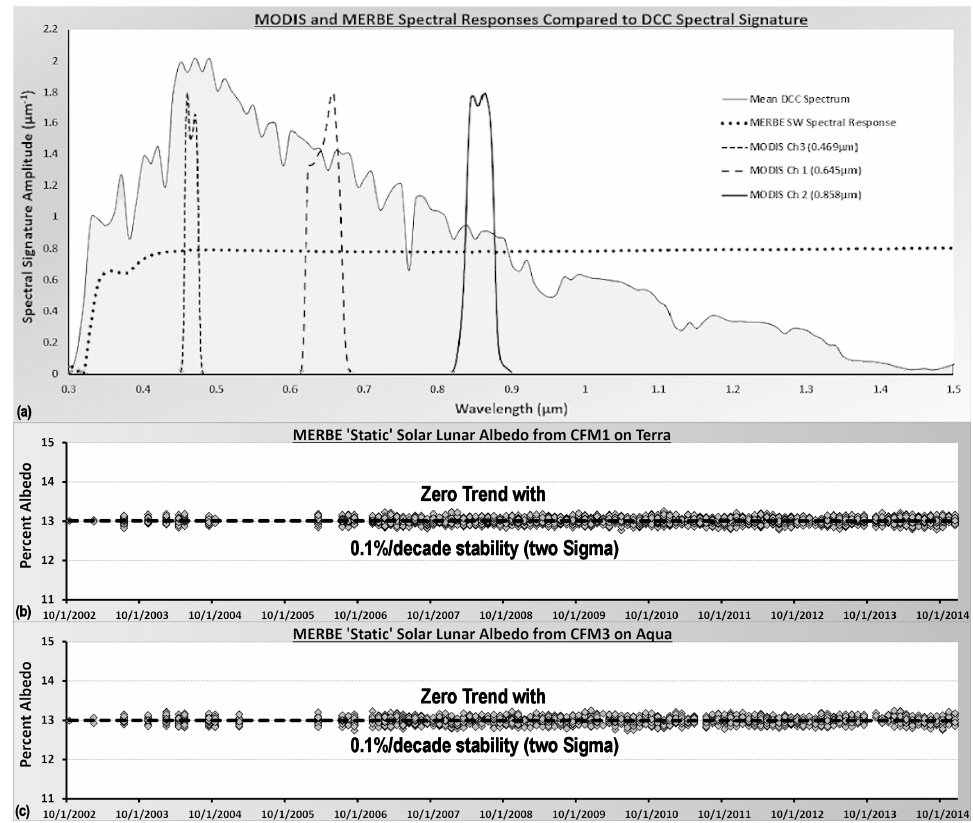
Figure 1. ( a ) MODTRAN 5.3 Deep Convective Cloud (DCC) spectral signature from MERBE, along with MERBE and MODIS Ch 1–3 Spectral responses. ( b , c ) MERBE Terra & Aqua measured lunar albedo by CERES Flight Model 1 & 3 (CFM1&3) giving 0.1%/decade stability (2 σ